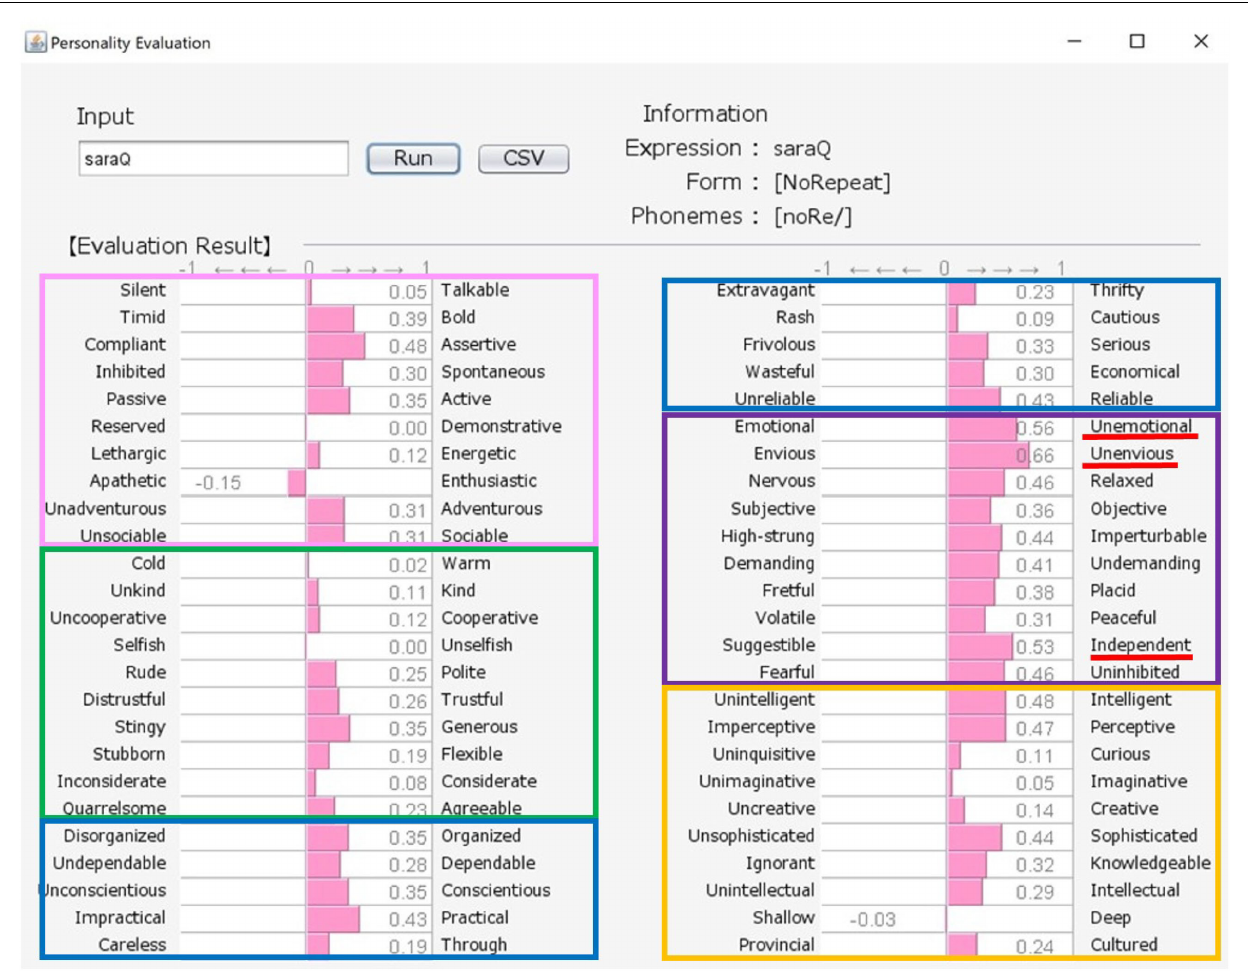
FIGURE 9 | Output for “saraQ (nearly equal to frank)” personality. The pink, green, blue, purple, and orange frames indicate Extroversion, Agreeableness, Conscientiousness, Neuroticism, and Openness, respectively.